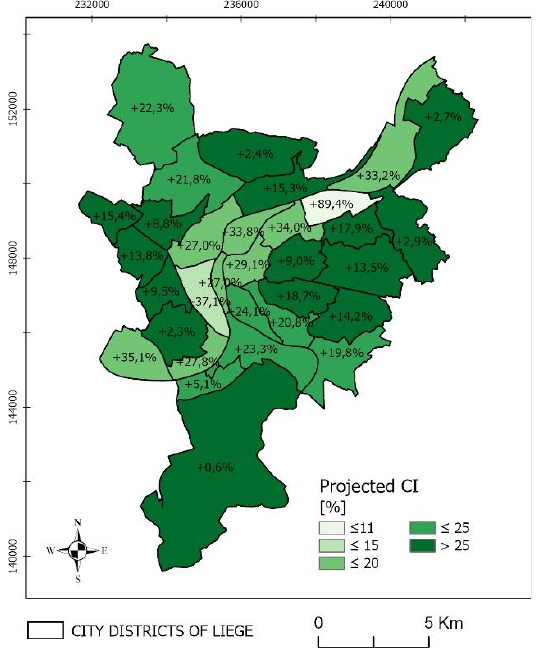
Figure 5. Projected CI in 2050 according to city greening strategy. Label represents the relative increase in CI per